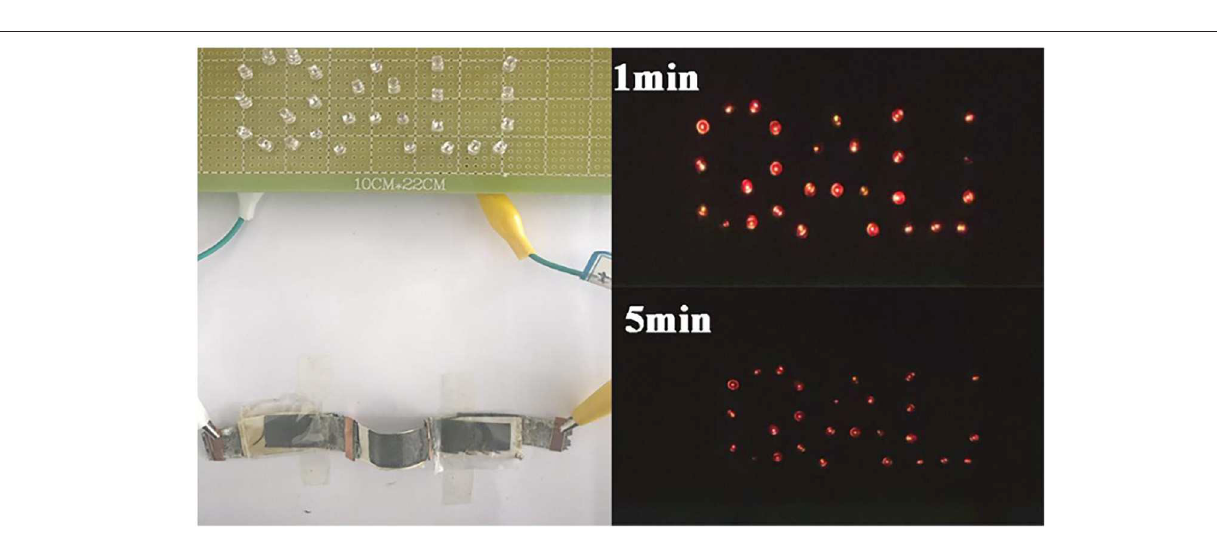
FIGURE 7 | Commercial LED lights powered by three ASC devices connected in